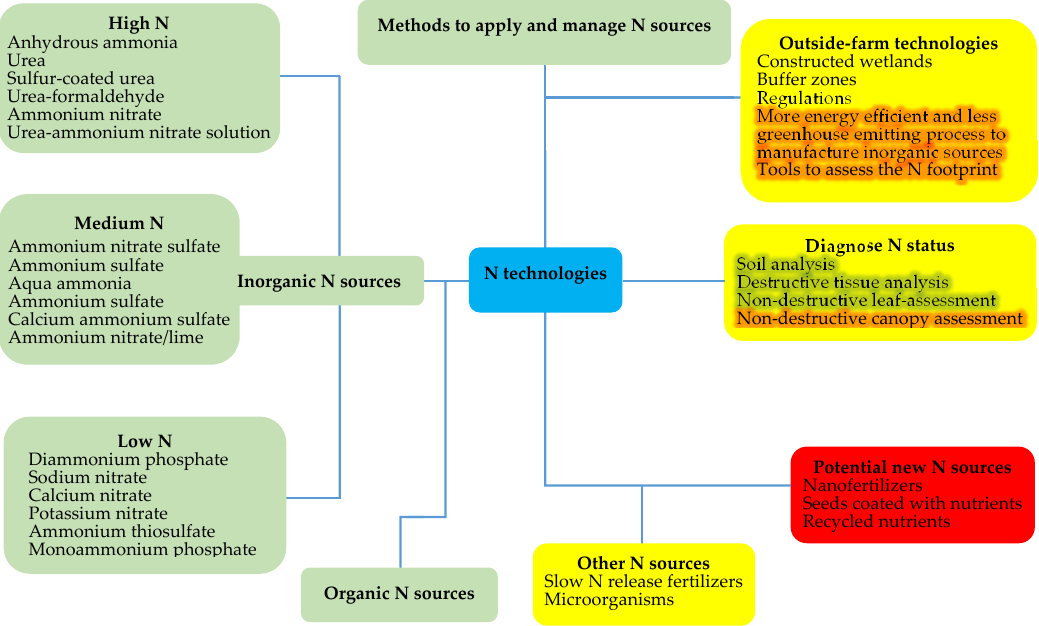
Figure 1. Mind-map of emerging and established technologies for increasing nitrogen use efficiency and reducing the environmental problems resulting from nitrogen fertilization. Red shows potential new technologies, yellow shows tested technologies with little adoption so far, and green shows established technologies.